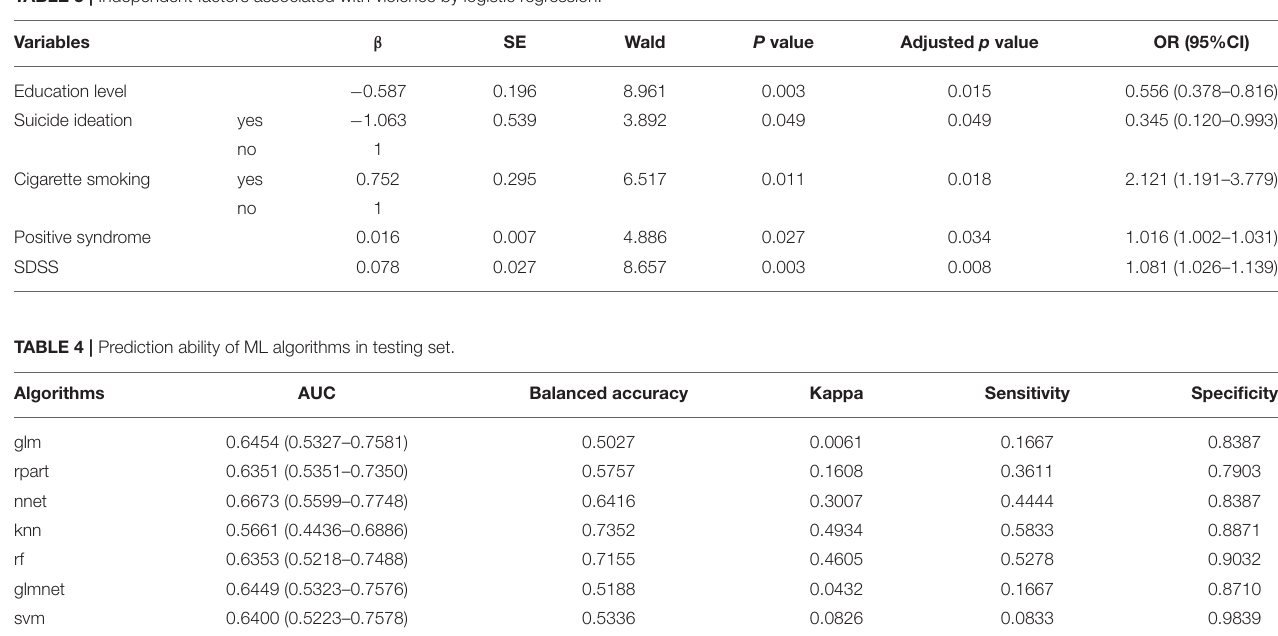
TABLE 3 | Independent factors associated with violence by logistic regression.